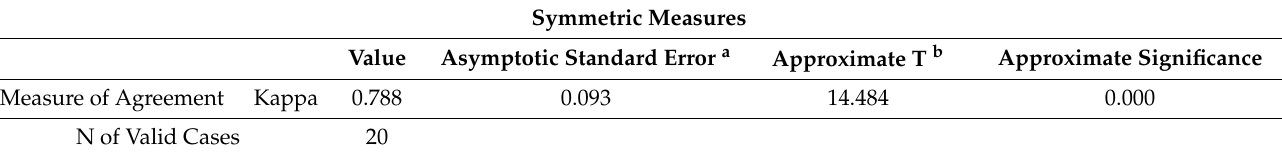
Table 7. Inter-rater reliability of the 12 items Life Satisfaction Index for the Third Age—Short Form